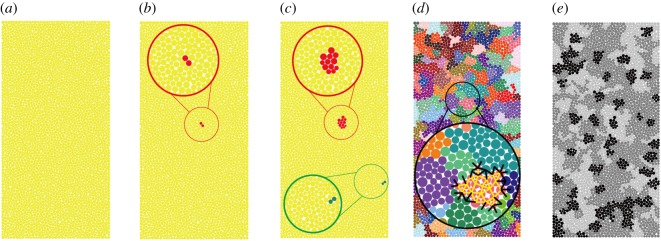
Particles extend cluster method: (a) the initial intact sample, (b) the beginning of the first cluster (red circles), (c) the first cluster finishes and the second one starts to generate (green circle), (d) the sample with all clusters (the black lines represent intergranular contacts and the yellow lines represent intragranular contacts) and (e) the distribution of minerals (light grey cluster represents quartz, dark grey feldspar and black biotite).